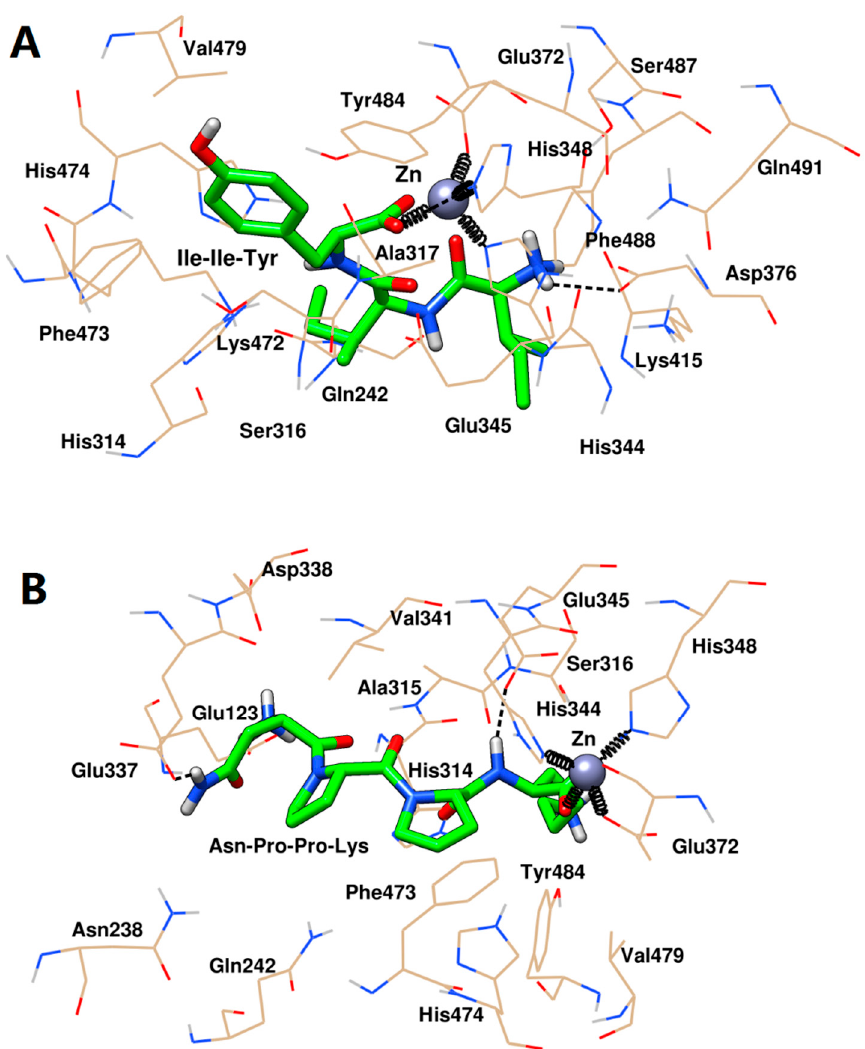
Figure 7. Docking conformation of Ile-Ile-Tyr ( A ) and Asn-Pro-Pro-Lys ( B ) with ACE. Gold lines represented the ACE residues involved in interacting with peptides. Green sticks represented the peptides. Grey sphere represented the Zn(II). Black dash lines represented the hydrogen bonds. Black springs represented the coordination bonds.